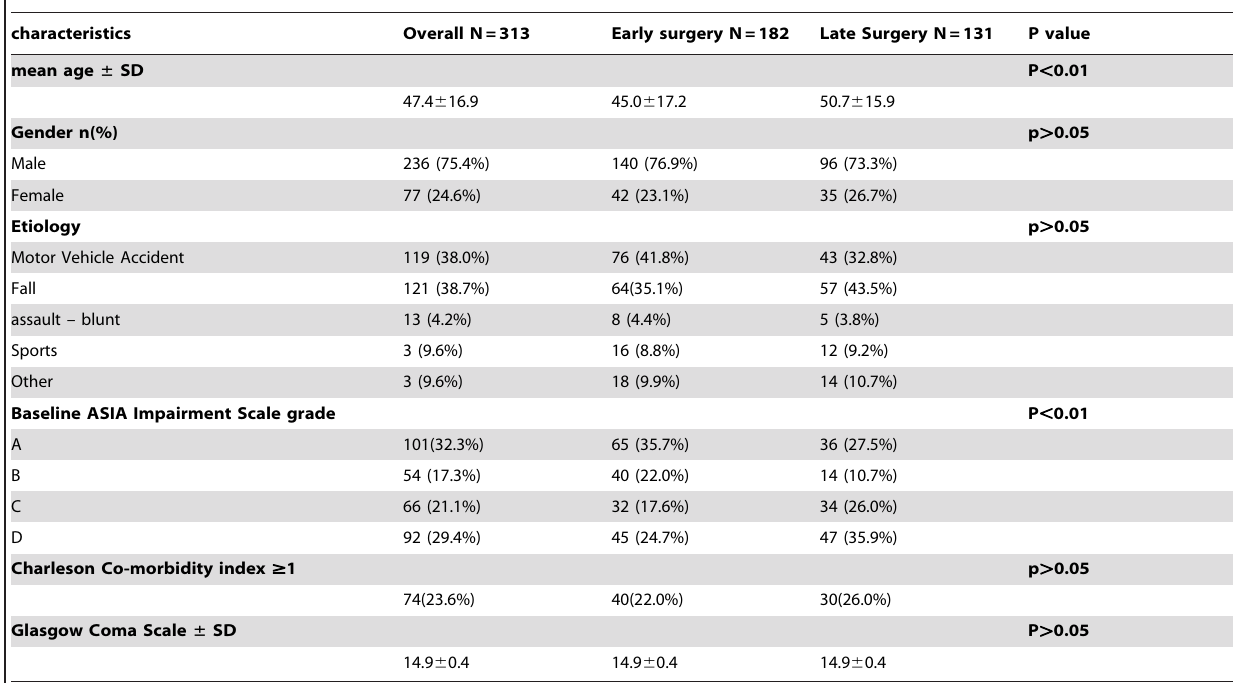
Table 2. Patient Demographics and Injury